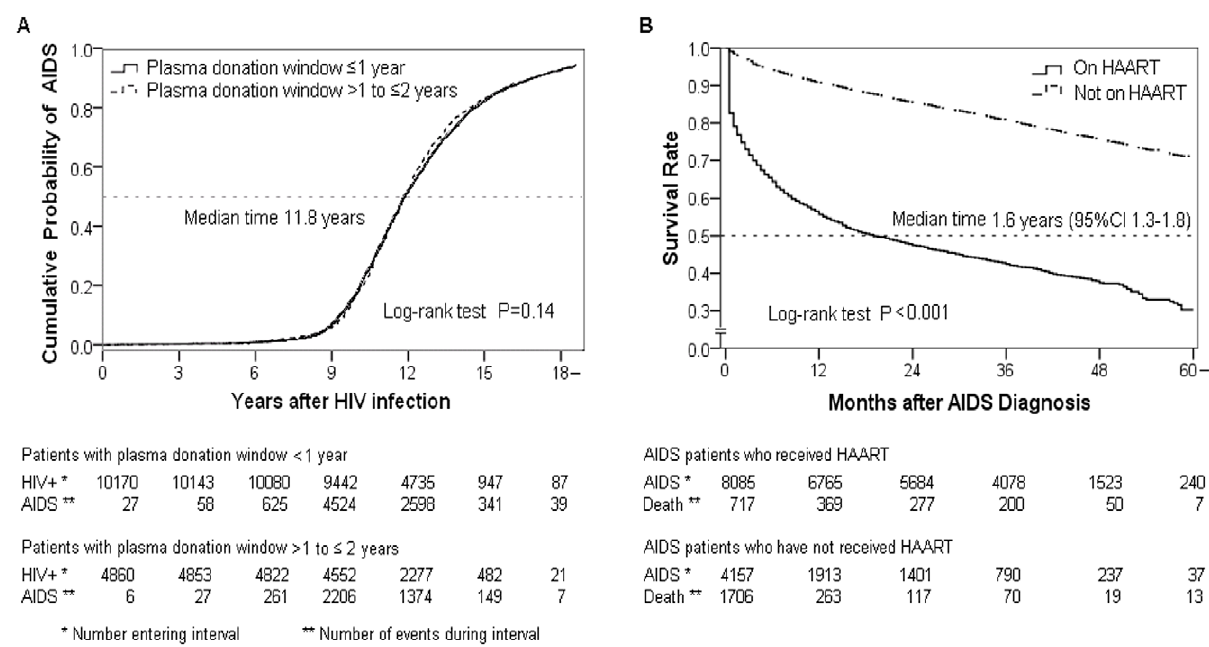
Figure 4. Survival from HIV infection to AIDS and from AIDS to death. Kaplan-Meier plots showing survival from HIV infection to AIDS in former plasma donors with plasma donation window # 2 years (Figure 4a, N=15030) and from AIDS to death among the same cohort who were diagnosed with AIDS (N=12242), stratified by whether or not on highly active antiretroviral therapy (HAART; Figure 4b).